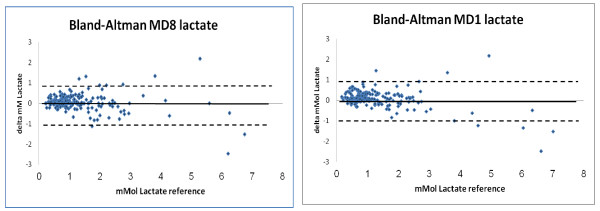
Bland-Altman plots. Mean reference blood lactate vs. microdialysis lactate, eight-hour calibration (MD8; left) and single calibration (MD1; right). Bold line: lines of equality; dotted lines: limits of agreement (1.96*SD).